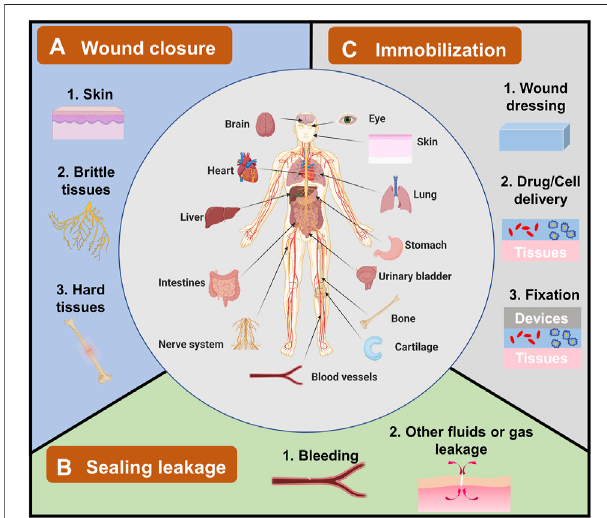
FIGURE 1 | The applications of bioadhesives in human bodies and their categories. Bioadhesives have been explored in human bodies in different organs, including the brain, eyes, heart, liver, and skin. Their applications can be grouped into three categories. (A) Wound closure, which has been used in topical skin, and brittle/hard tissues. (B) Sealing leakage, including most explored blood leakage and other fl uids or gas leakage. (C) Immobilization for wound dressing, drug/cell delivery, and fi xation of